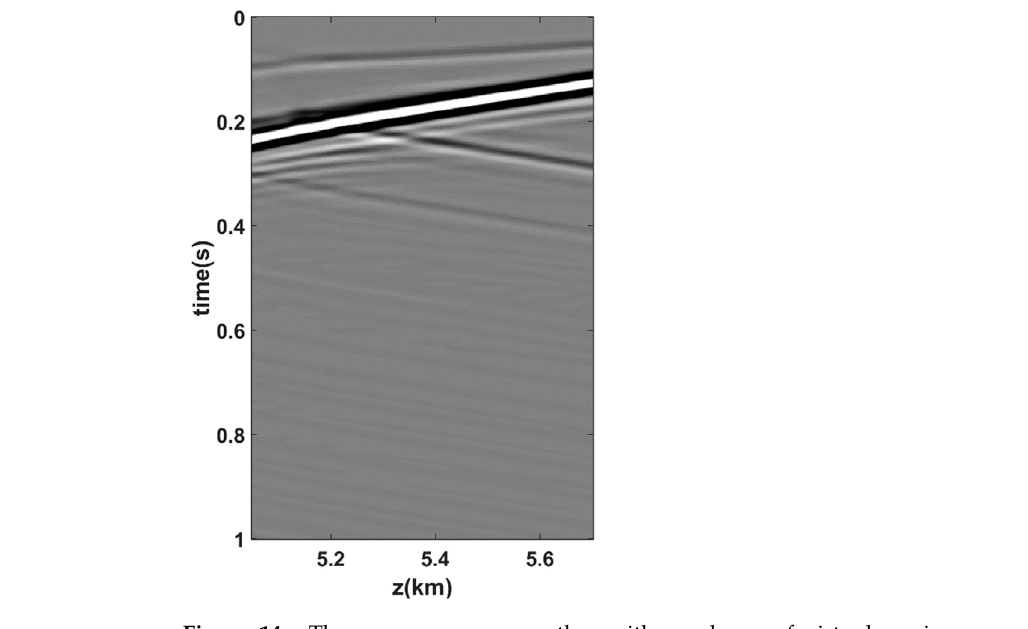
Figure 14. The common source gather with a column of virtual receivers x vr = (X: 2155 m, Z: 5555–6185 m) corresponding to a virtual source at x vsp = (X: 2500 m, Z: 6600 m) obtained by the VSP Marchenko source-receiver redatuming with a small aperture.